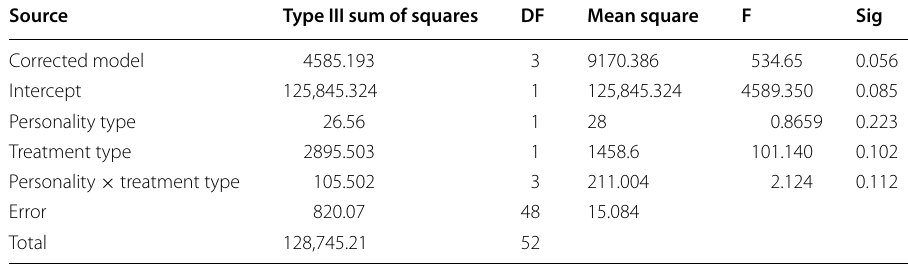
Table 3 Two-way ANOVA for scores on pretest Source